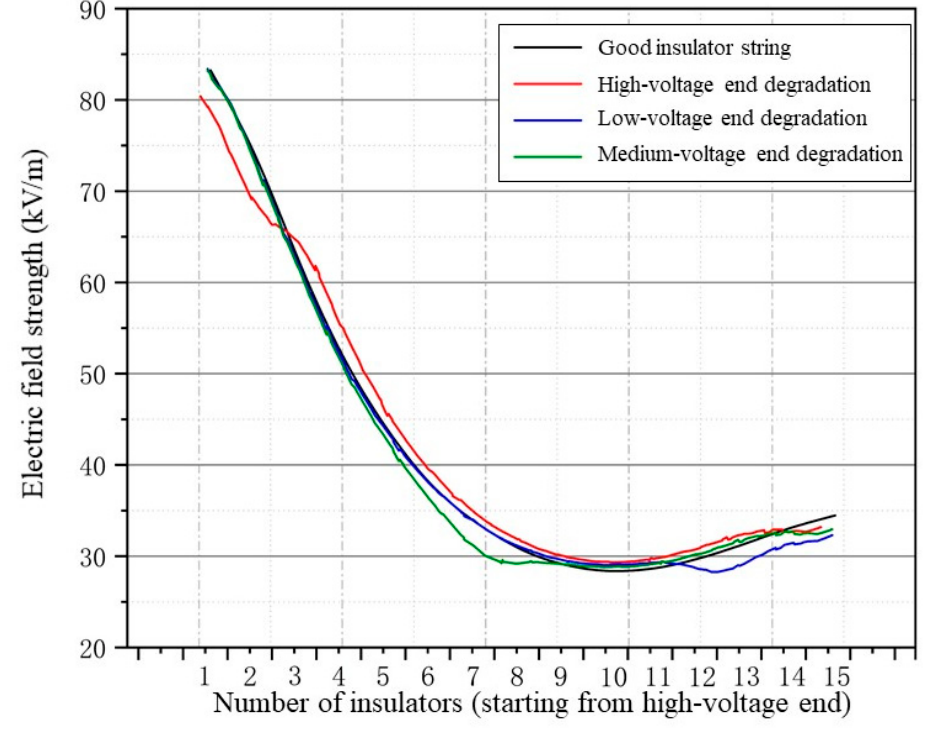
Figure 1. Electric field distribution of degraded insulators. According to the insulator degradation curve, when the insulator string is degraded at the high-voltage end, medium-end voltage, and low-voltage end, the value of the electric field in the surrounding space is significantly reduced. The field strength of the high-voltage end degradation point is 67.8 kV/m, with a decrease of 16.7% compared with normal; the field strength of the medium-voltage end degradation point is 29.7 kV/m, with a decrease of 9.8%; the field strength of the low-voltage end degradation point is 28.2 kV/m, with a decrease of 15.2%. It is obvious the space electric field distortion is the most obvious at the high-voltage and low-voltage ends of the insulator string. The traditional electric field distribution detection method is to collect electric field information of insulator strings through a fixed detection path and compare the electric field curves of insulator strings with good performance and with degradation to make